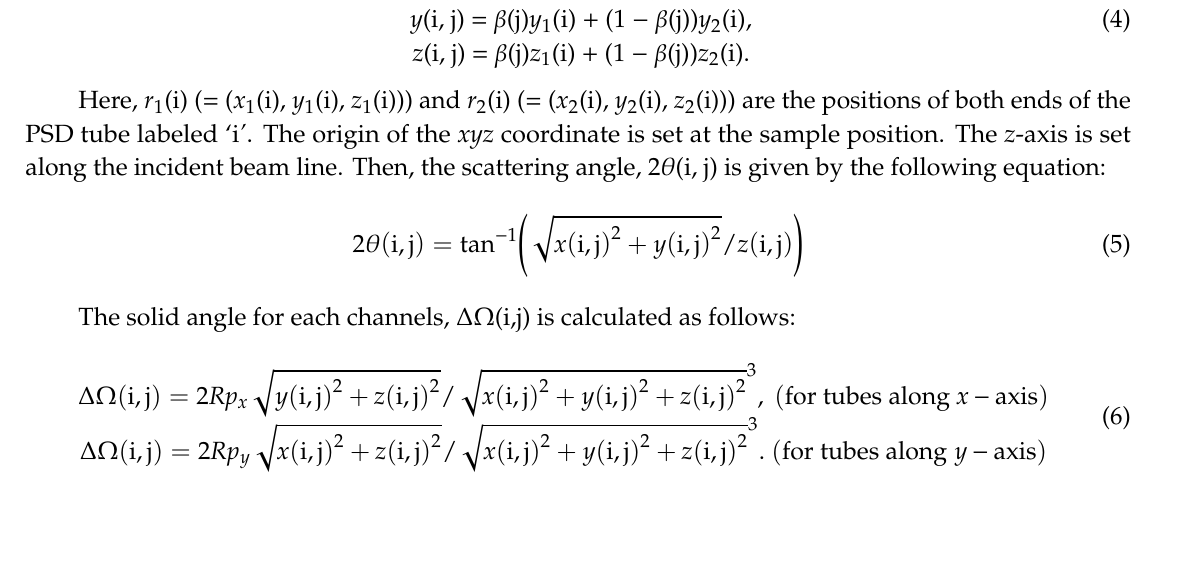
Figure 6. Scheme of event-mode data histogramming.